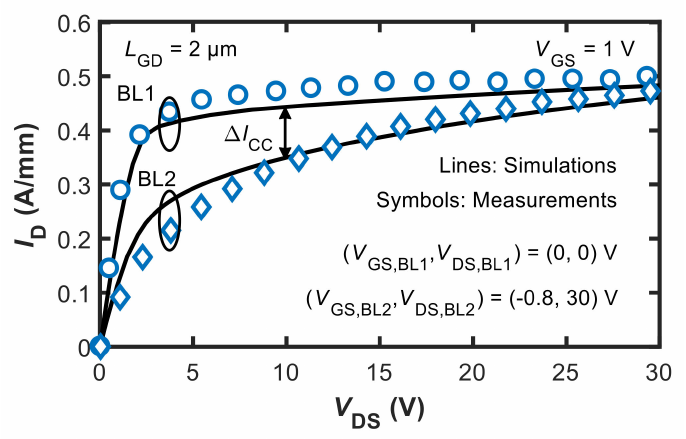
Figure 3. Calibrated pulsed I D – V DS curve simulations (lines) showing the achieved agreement in current-collapse measurements from [1] (symbols). Adapted from